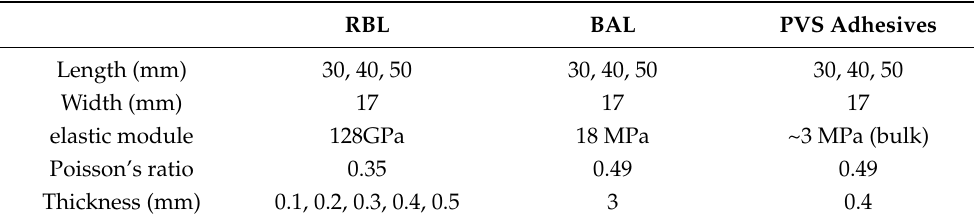
Figure 5. ( A ) Structural parameters and test conditions of the rigid-flexible coupling adhesive unit; ( B ) images of the contact area and boundary extraction acquired by the FTIR contact test system; ( C ) contact force and contact angle of the rigid-flexible coupling adhesive unit in the pre-press and peel stages acquired by the UMT mechanical test system. Table 1. The specific geometric parameters and mechanical properties of the